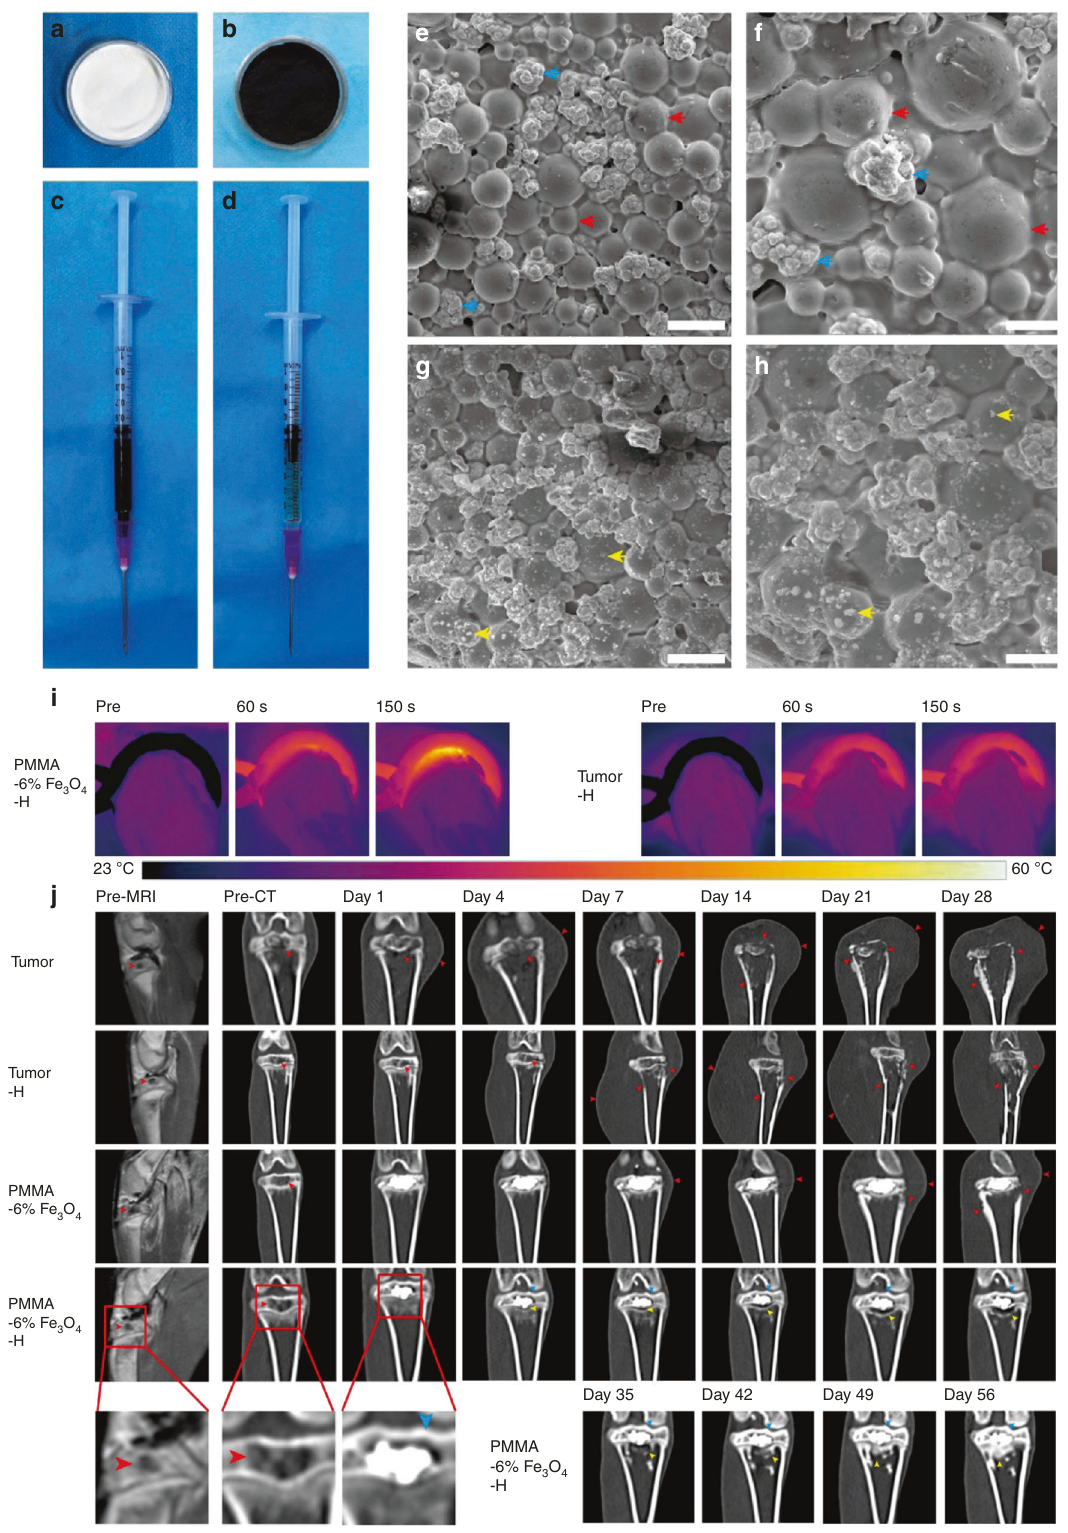
Fig. 3 PMMA-Fe 3 O 4 for magnetic ablation of bone tumors and bone repair. a PMMA powder, b Fe 3 O 4 nanoparticles, c MMA monomer, and d injectable PMMA-6% Fe 3 O 4 . e Low-magni fi cation SEM image of polymerized PMMA. The scale bar is 50 μ m. f High-magni fi cation SEM image of polymerized PMMA. The scale bar is 20 μ m. g Low-magni fi cation SEM image of polymerized PMMA-6% Fe 3 O 4 . The scale bar is 50 μ m. h High-magni fi cation SEM image of polymerized PMMA-6% Fe 2 O 3 . The scale bar is 20 μ m. i Thermal images of rabbit legs in the PMMA-6% Fe 3 O 4 – H group and Tumor-H group. j Enhanced MRI images and coronal reconstructed CT images at each follow-up time point (red arrow: bone destruction and swelling of soft tissue, blue arrow: cortical bone of upper tibial plateau, yellow arrow: area of bone resorption and